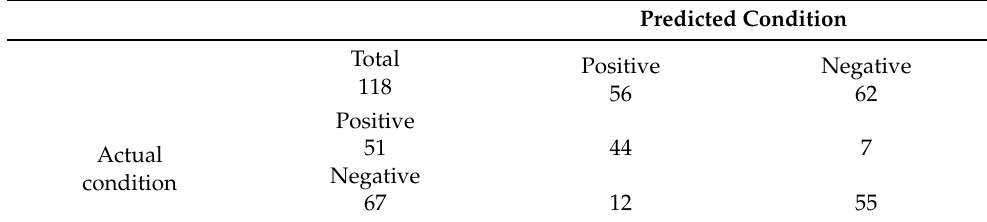
Table 4. Confusion matrix for CNN Topology 3.